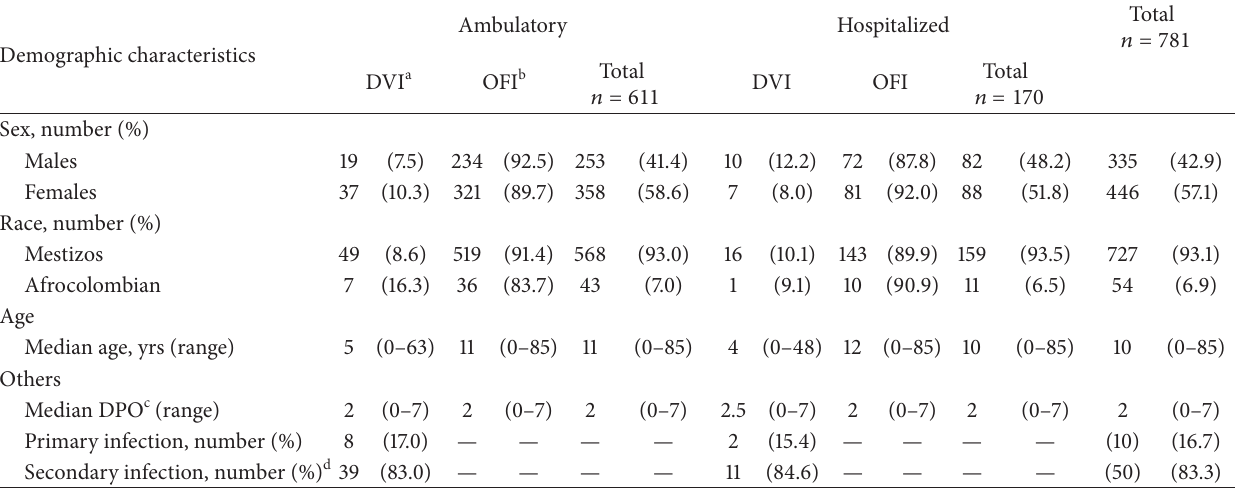
Demographic characteristics